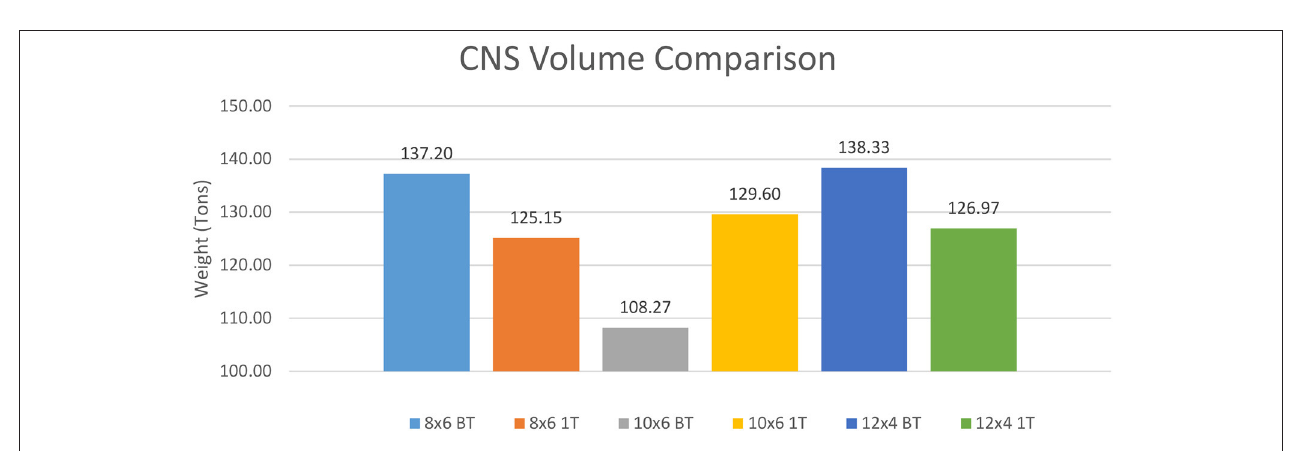
FIGURE 3 | Chip and Saw Volume Comparison for all Ptaeda